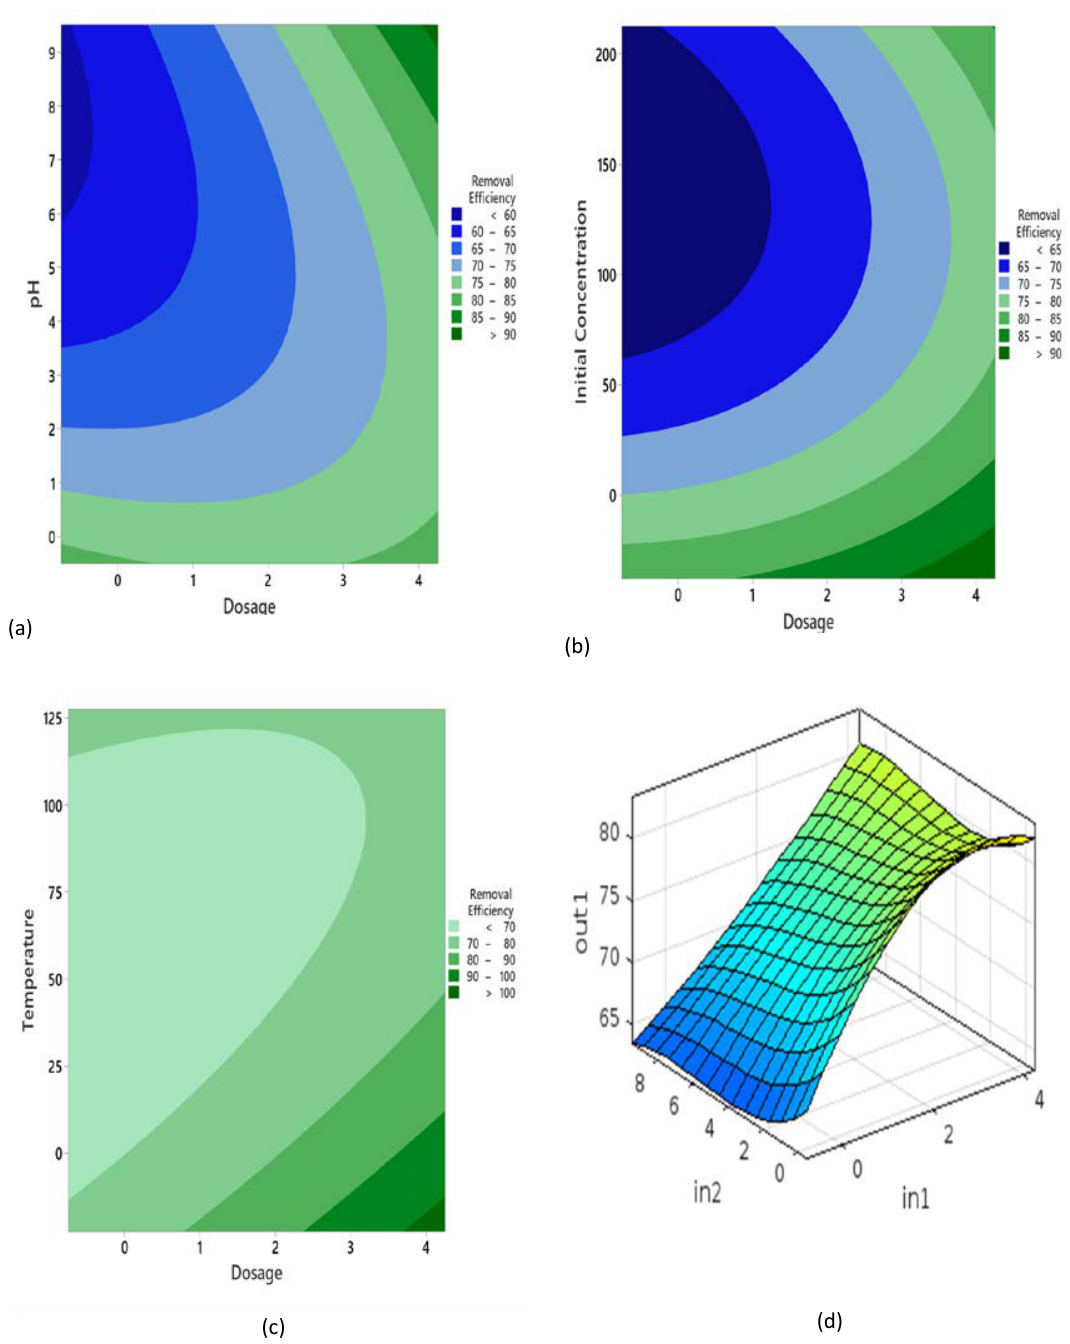
Fig. 9 : (a) Contour plot of removal efficiency vs pH, dosage (b) Contour plot of removal efficiency vs initial concentration, dosage (c) Contour plot of removal efficiency vs. temperature, dosage (d) ANFIS surface plot for batch